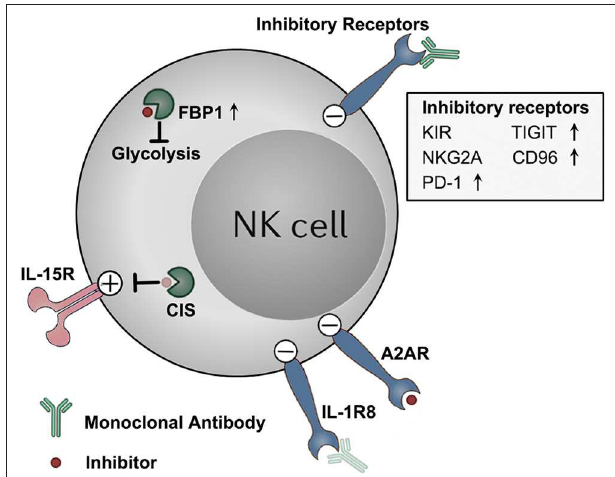
FIGURE 1 | Targeting NK cell dysfunction via checkpoint inhibition tumor immunotherapies. NK cells display a dysfunctional status in tumors, along with detrimental upregulation of some checkpoint molecules (e.g., TIGIT, CD96, PD-1, and FBP1). These molecules, as well as other constitutively expressed checkpoint molecules (e.g., KIRs, NKG2A, A2AR, and IL-1R8), functions to impair the anti-tumor effector potentials of NK cells in tumors. These checkpoint molecules represent potential targets for NK–based immunotherapy. Therapeutically targeting these molecules by blocking monoclonal antibodies or small molecule inhibitors might unleash NK cells from those immune suppressive mechanisms, and boost NK cell anti-tumor activity. Antibody and inhibitor symbols in light color (those for CIS and IL-1R8) indicate that the agents have not been developed